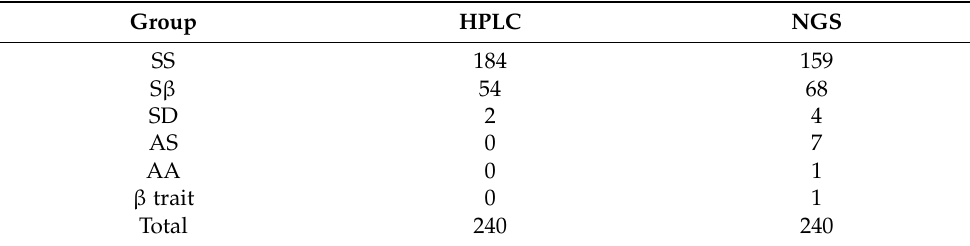
Table 2. Distribution of Hb genotypes of patients in the study.